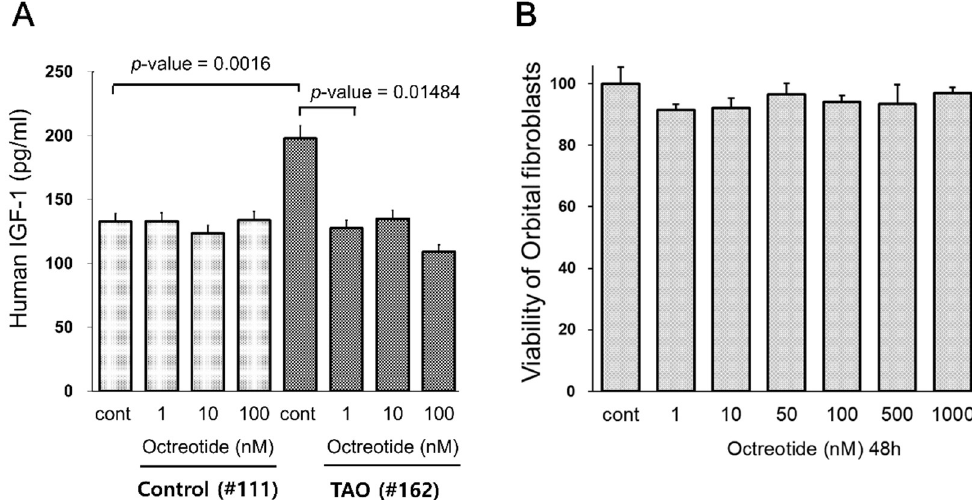
Fig 2. Treatment with octreotide reduced the levels of IGF-1 secretion in OFs from patients with TAO. (A) OFs were plated at a concentration of 2 x 10 5 cells/well in a 6-well plate. After 24 hours, cells were treated with octreotide at the indicated concentration for 24 hours. The culture medium from one control individual (#111) and one patient with TAO (#162) was analyzed for IGF-1 content with ELISA. (B) OFs, which were derived from a control (#111), were treated with octreotide at the indicated concentrations for 48 hours. Cell viability was determined using an MTT assay.